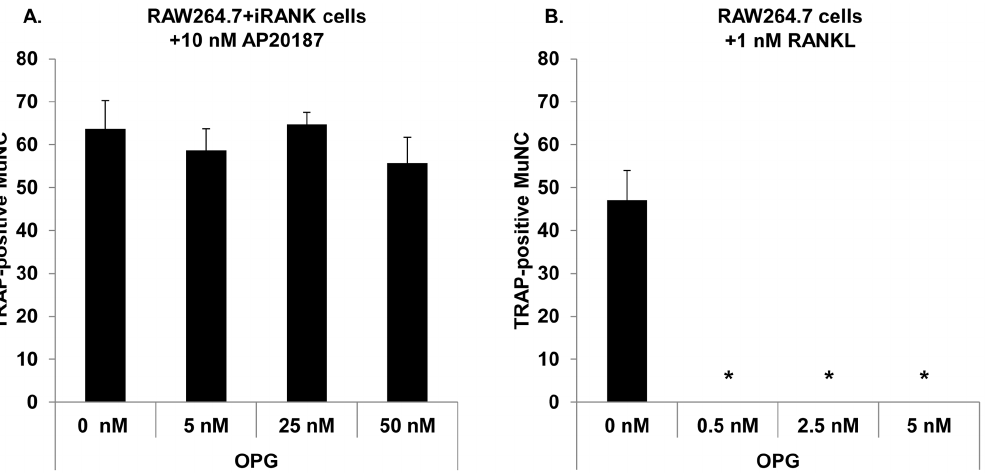
Figure 9. CID induced osteoclastogenesis in RAW264.7 + iRANK cells is OPG-independent. TRAP-positive multinucleated cells (MuNC) after treatment of RAW264.7 + iRANK cells with 10 nM AP20187 (A) or RAW264.7 cells with 1 nM RANKL (B) in the presence of increasing concentrations of OPG. TRAP-positive multinucleated cells (MuNC) were counted over 4 high power fields of view and averaged over 3 wells. *p , 0.05 compared to 0 nM OPG.